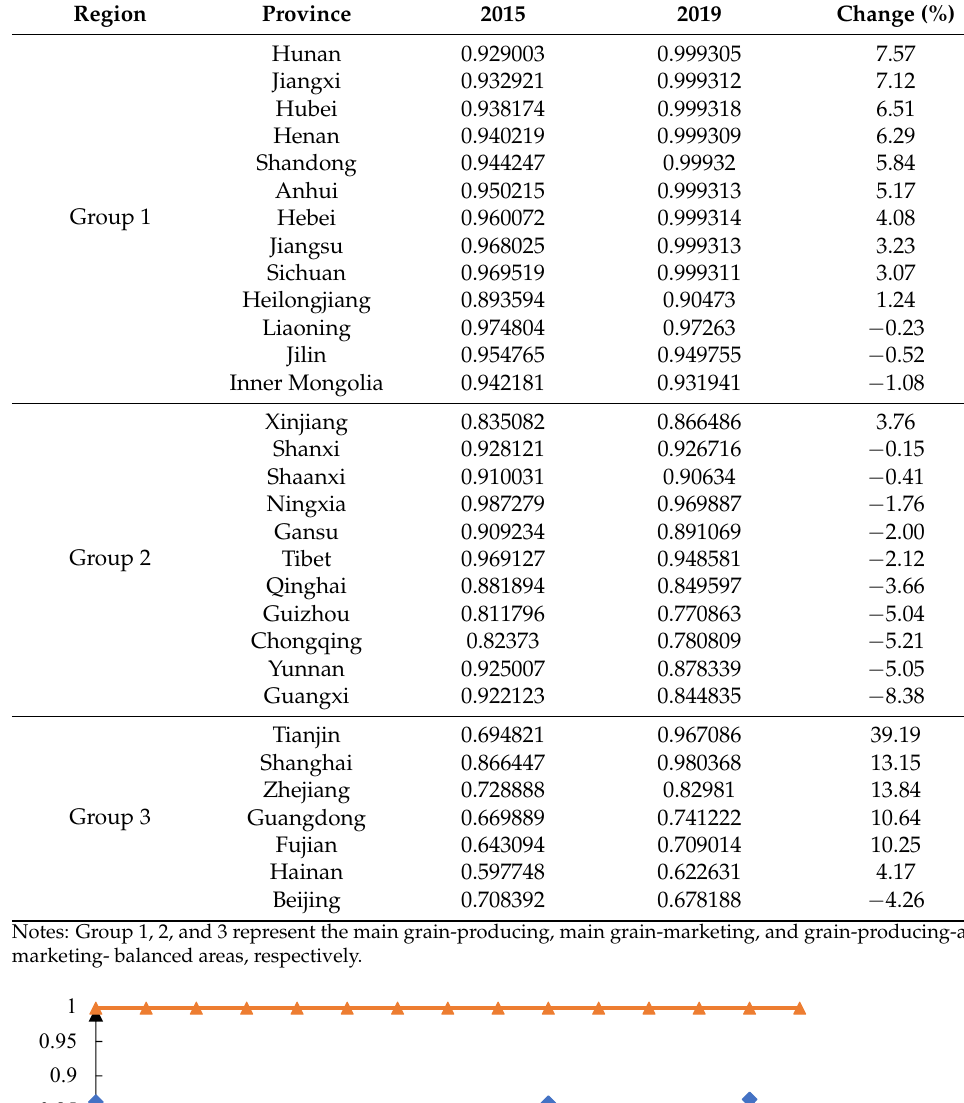
Table 3. Ranking of fertilizer use efficiency in 31 provinces.